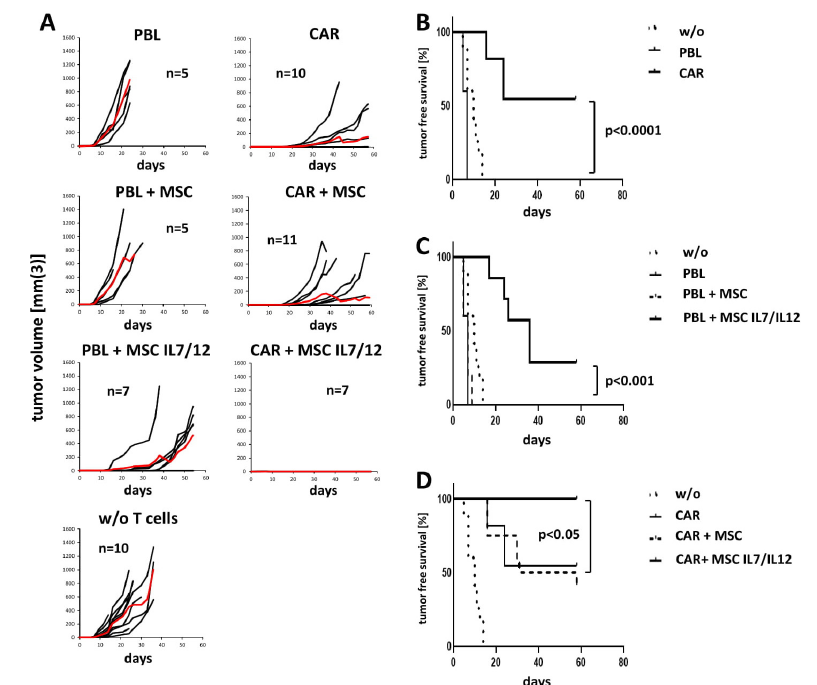
Figure 7. IL7 and IL12 secreting MSCs support an anti-tumor response in vivo. NSG mice (5–12 animals/group) were subcutaneously co-injected with LS174T tumor cells (2.5 × 10 6 /mouse), anti-CEA CAR T cells or non-modified T cells (2 × 10 6 /mouse) in presence or absence of non-modified or IL7 and IL12 secreting MSCs (4 × 10 5 /mouse). Tumor growth was monitored every 2–3 days. Onset of tumor growth was determined at tumor size >20 mm 3 . The experiment was terminated on day 58. ( A ) Tumor growth of individual animals; red line represents mean values. (b-d) Kaplan Meier plots of data with tumor free survival. ( B ) Comparison of groups with non-modified and CAR T cells; ( C ) comparison of groups with non-modified T cells in presence or absence of MSCs and IL7/IL12 secreting MSCs; ( D ) comparison of groups with CAR T cells in presence or absence of MSCs and IL7/IL12 secreting MSCs. Statistical analysis was determined by the Logrank-test.